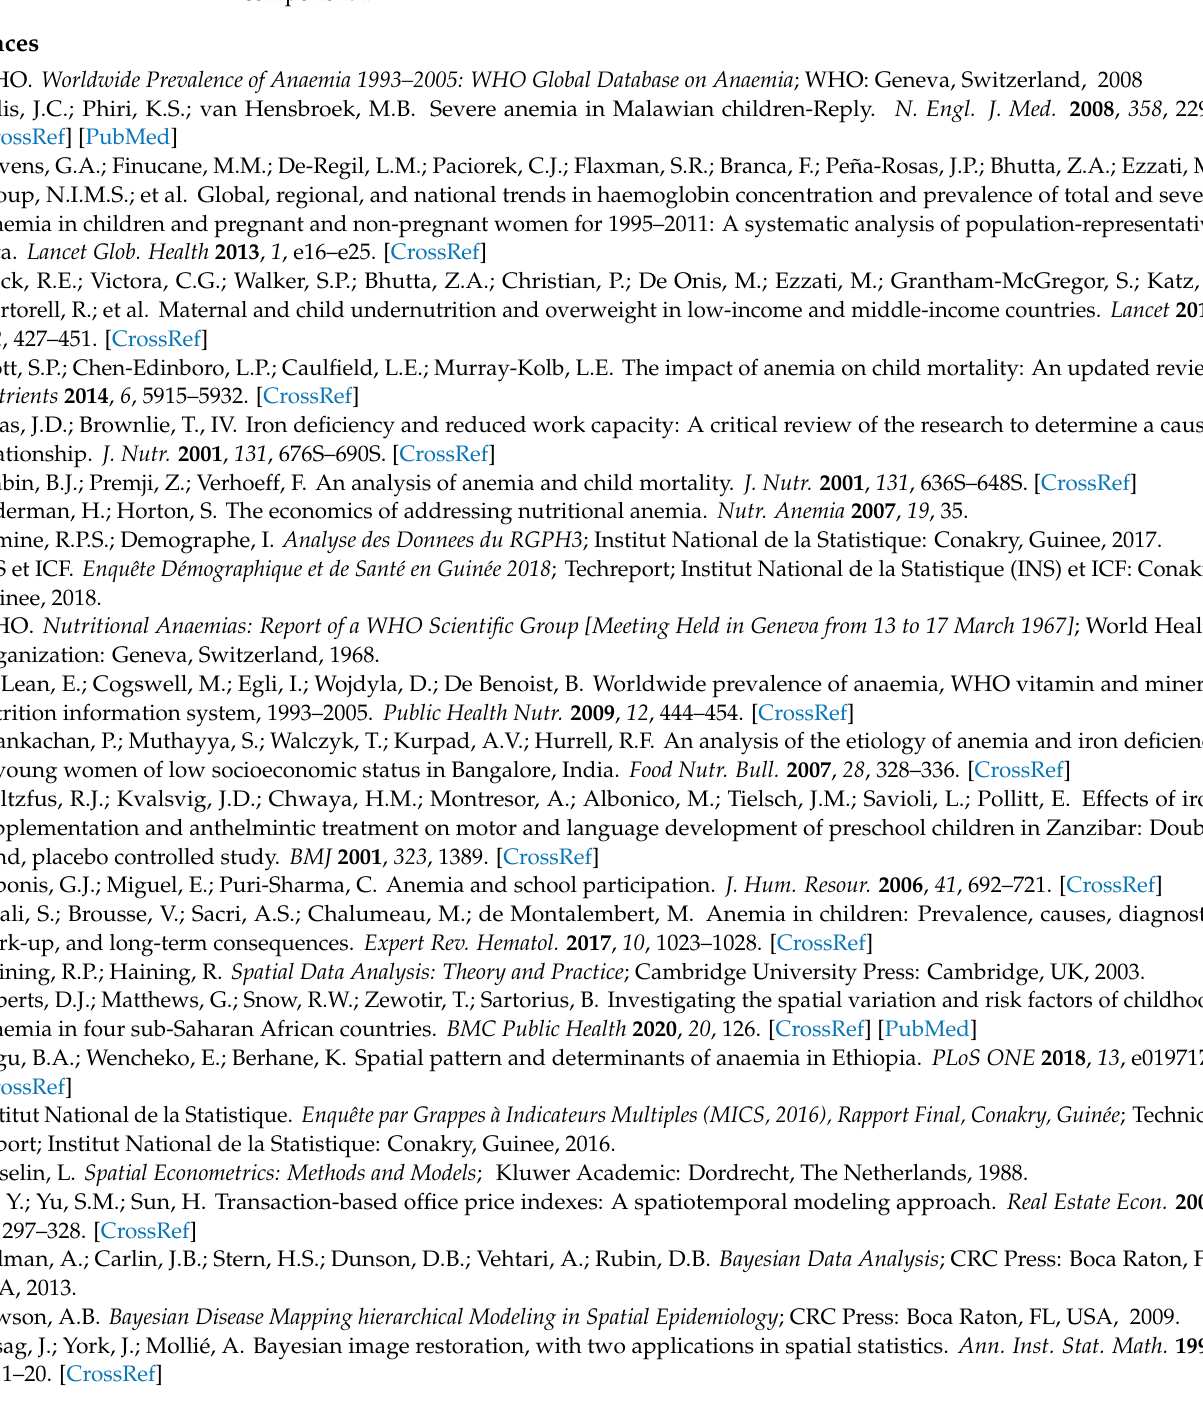
Figure A4. ( a ) Posterior mean of the non-spatial component v . ( b ) Posterior mean of the spatial component u